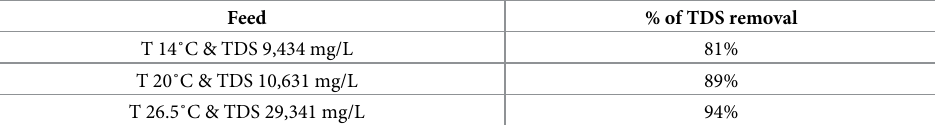
Table 1. The TDS removal percentage of the EDR at different feed temperatures. (Feed flow rate = 12 L/h, water recovery ratio for TDS 6764 mg/L = 75% and for TDS 9434 mg/L = 52% and TDS 29341 mg/L = 23% the applied volt- age = 24 V).